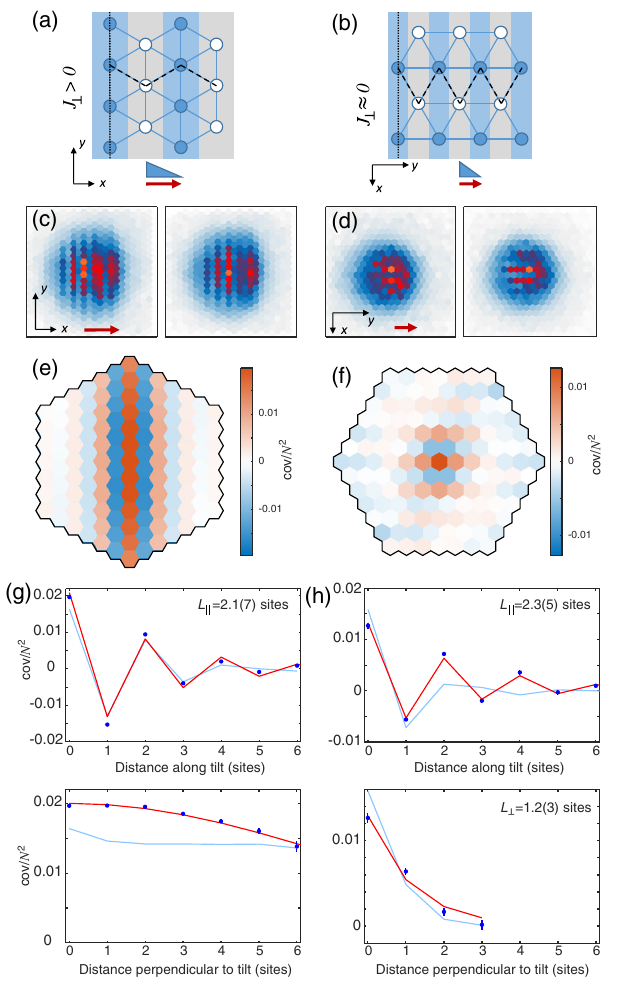
FIG. 4. Dependence on the tilt direction. (a) Sketch of the triangular lattice geometry and the columns (gray and blue bars) perpendicular to the tilt for the two situations with different values of transverse tunneling J ⊥ . (b) Sketch of the situation with the tilt in the perpendicular direction. Here tunneling within the columns only appears as a higher-order process. For an easier comparison, we have rotated the system, such that the tilt always points to the right. (c),(d) Typical experimental images for the two tilt directions with energy offset Δ ¼ h × 1 . 4 kHz, a hold time of 60 ms, and a maximum atom number per tube of 900 and 850, respectively. The orientation of the images and the tilt direction (red arrow) are as in (a) and (b), respectively. (e),(f) The density correlation functions (Appendix D) for the two cases. (g),(h) Cuts of the density correlation functions show the density-wave order measured along a zigzag path along the tilt direction [dashed line in (a) and (b)] and a monotonic decay within the columns [dotted line in (a) and (b)]. The red lines show heuristic fits (Appendix D) to the data, the light blue lines result from the same analysis on T=J ¼ 50 . All error pictures from numerical simulations with k B bars correspond to the 68% confidence interval. Note that while (d) and (f) give the visual impression of horizontal stripes, they should be thought of as vertical stripes [as sketched by the blue and gray coloring in (b)]. This is because the horizontal bonds (which would connect the supposed horizontal stripes) are suppressed by 2 Δ in the effective